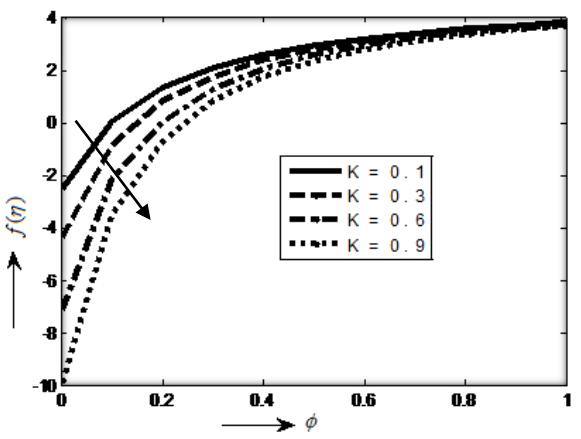
Figure 9. Variation of fluid velocity f (  ) against  for permeability parameters K (0.1, 0.3, 0.6, 0.9) by taking parameters  = 1.6, M = 2 and Re = 0.5